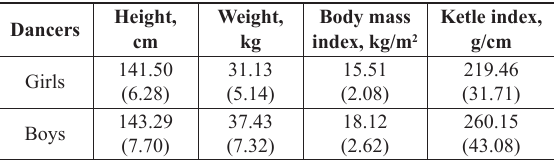
Figure 1. Heart rate indices of juvenile sports dancers during the Standard dance contest